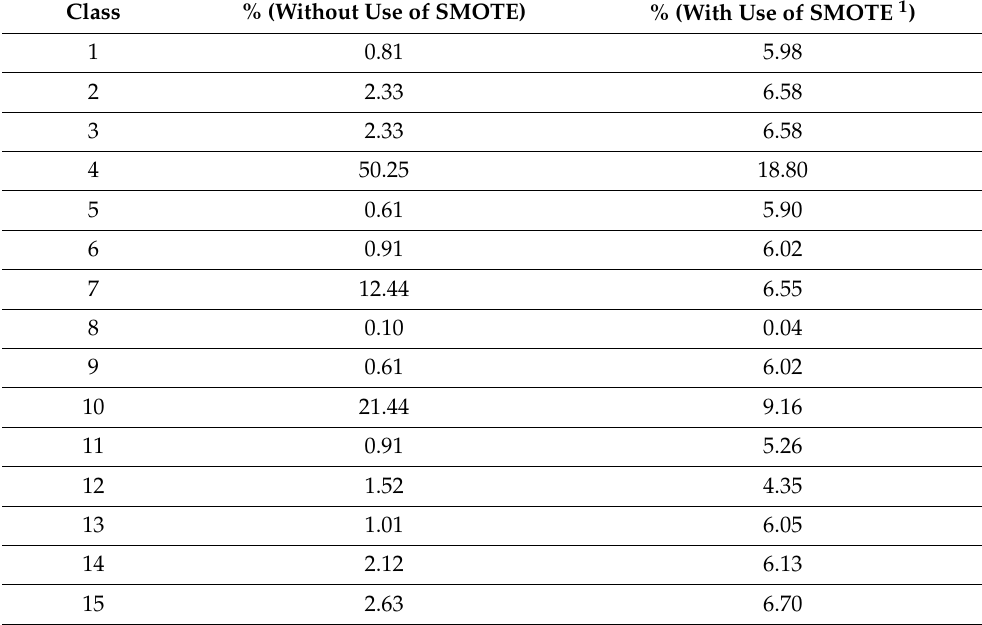
Table 2. Checking the percentage of data for each class in the prepared energy decomposition feature dataset with or without the use of